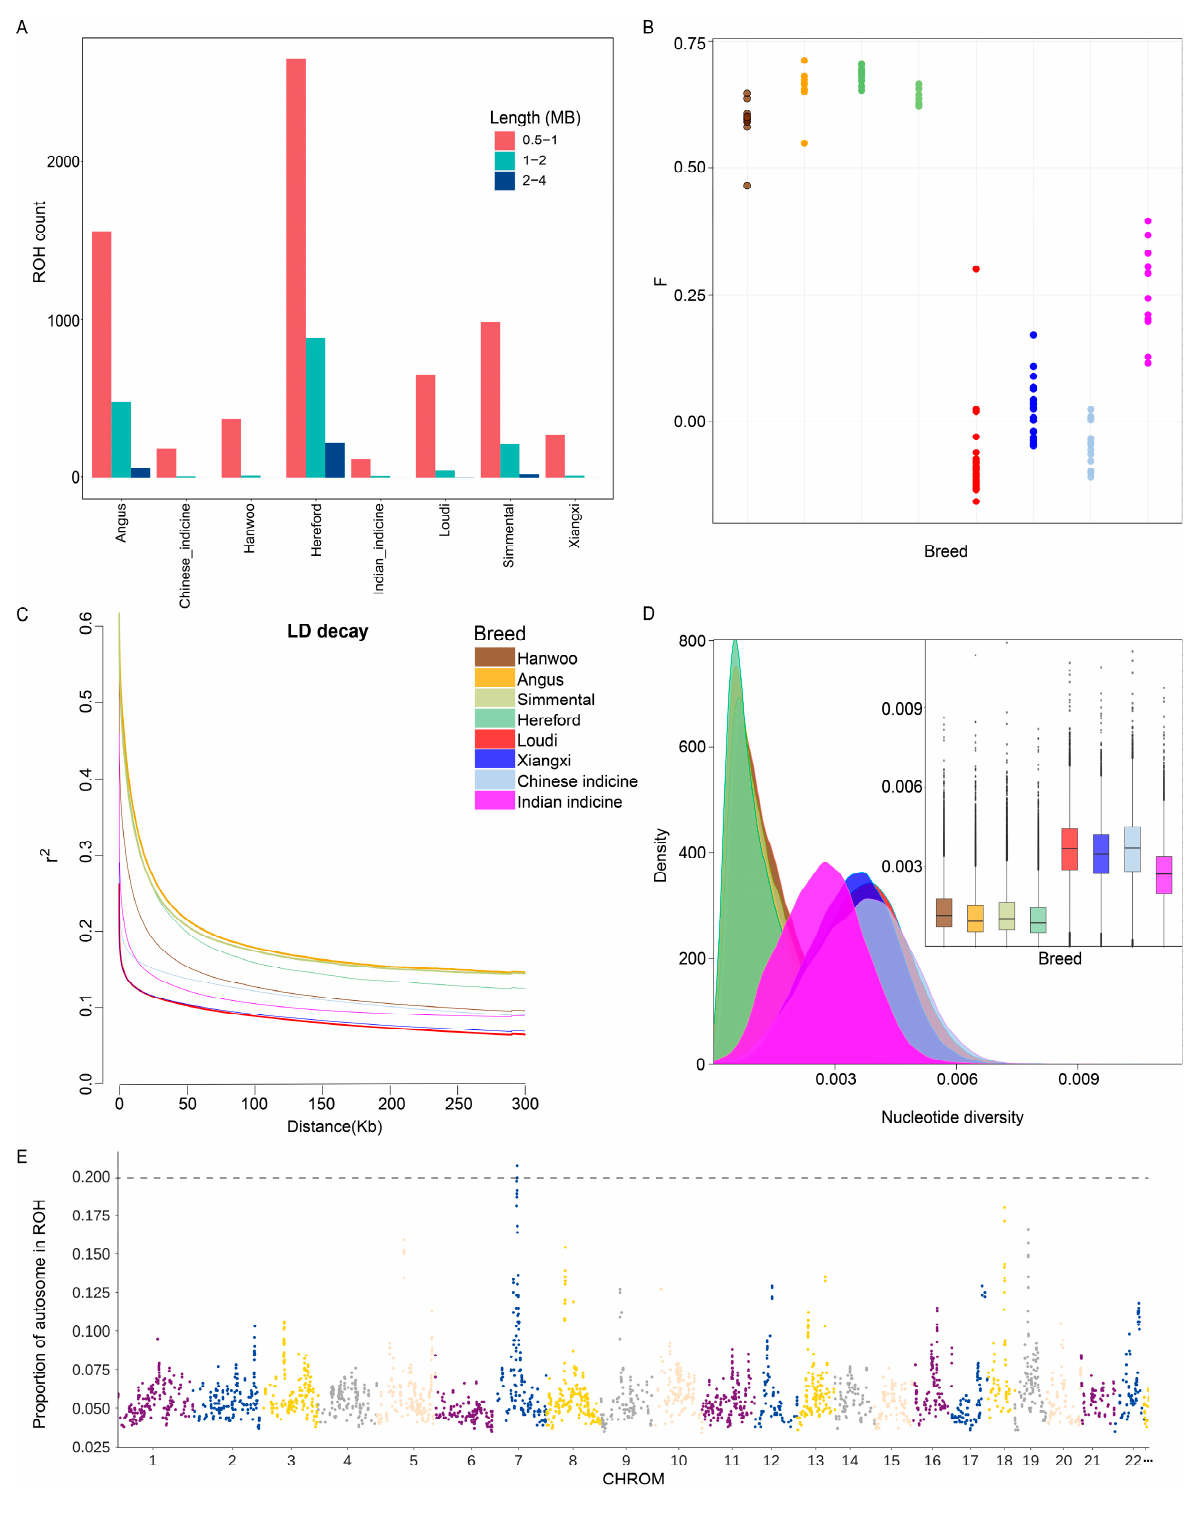
Figure 1. Genetic diversity analysis of 125 samples from 8 populations, among which ( B – D ) shared the same legend and color. ( A ) Bar chart of ROH analysis. Red represents ancient inbreeding, while green and blue represent historical and recent times, respectively. ( B ) F-coefficient for genomic heterozygosity estimates. ( C ) Decay of LD in the 8 cattle populations, with one line per population. ( D ) The nucleotide diversity for each group by density plots and box plots. ( E ) Manhattan plots of ROH frequencies in Loudi cattle.